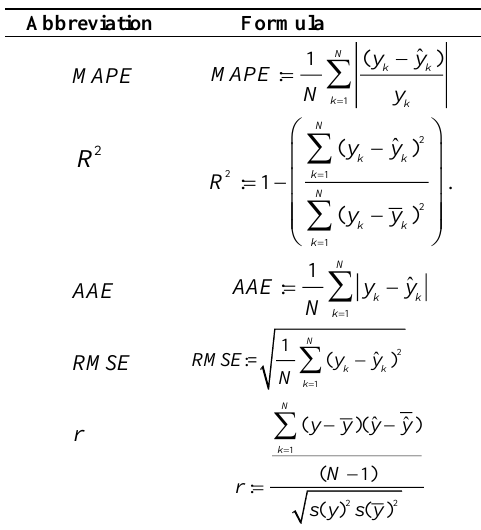
Table 1 . Performance measures and their